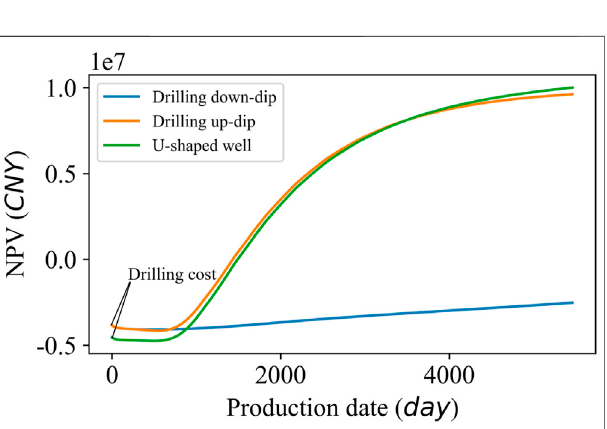
FIGURE 9 | Comparison of NPVs of different well drilling